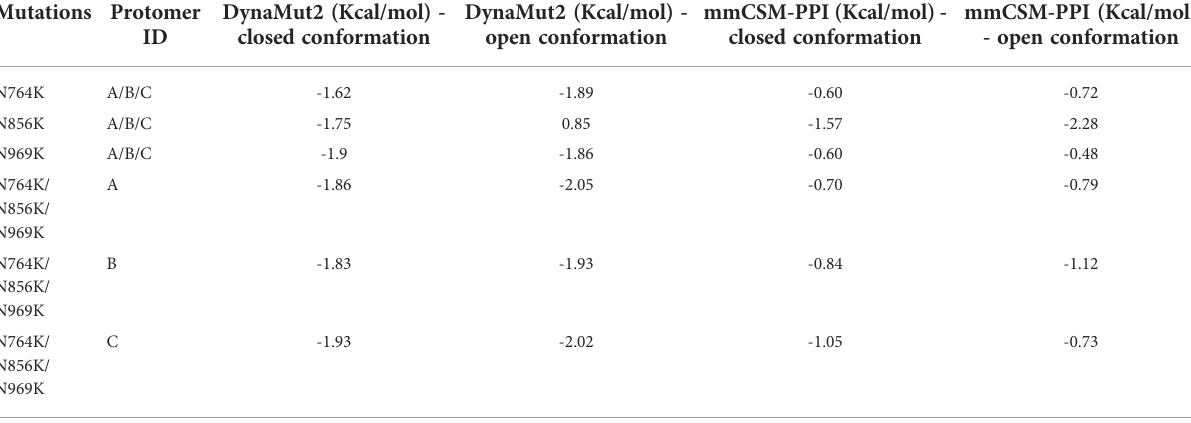
TABLE 3 The effects of Omicron multiple-site mutations on protein thermostability and stability of the trimeric Spike protein. Mutations Protomer ID